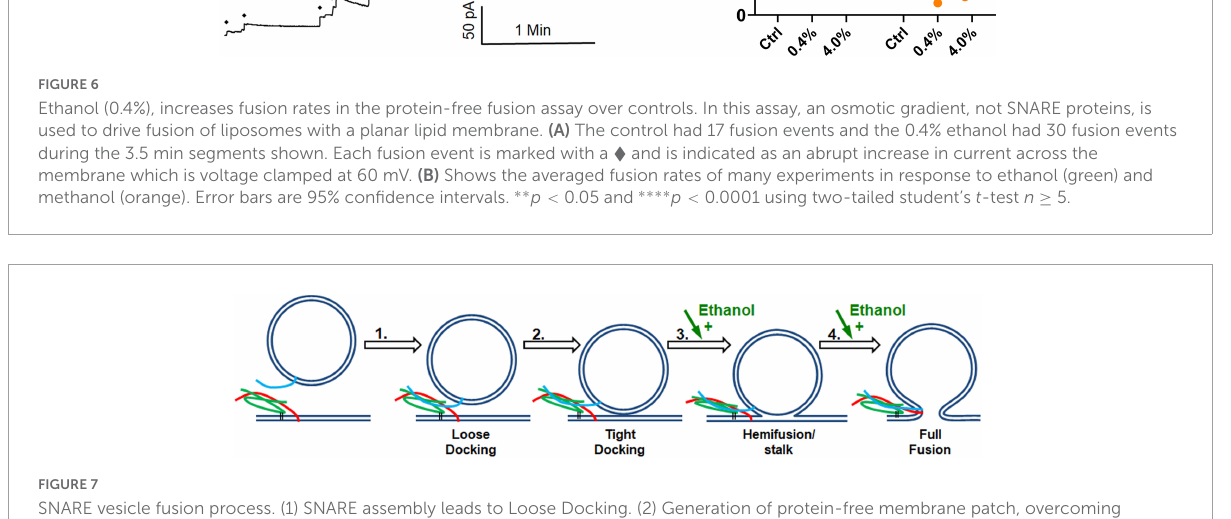
(loose and tight docking) and the last transition (full